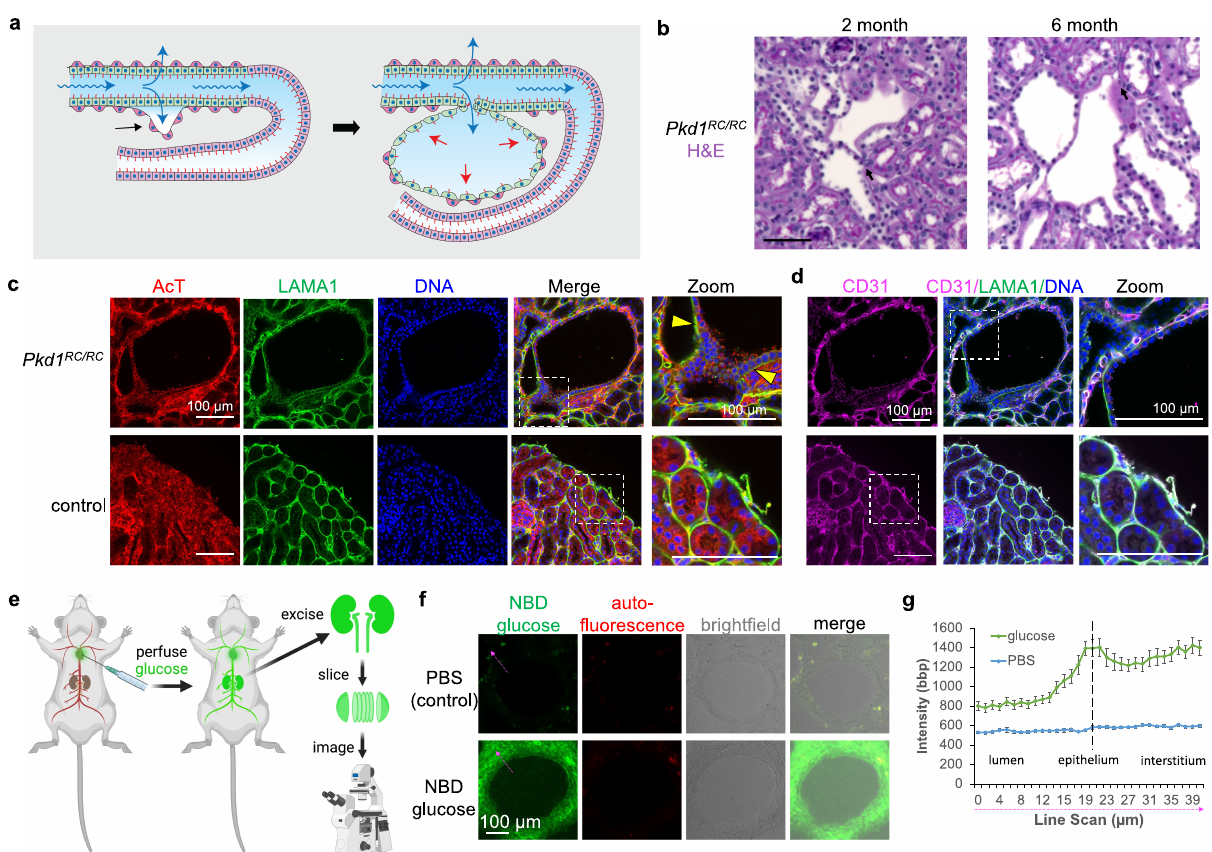
Fig. 6 | PKD cysts in vivo absorb glucose into the surrounding interstitium. a Hypotheticalschematicofabsorptivecystformationinkidneytissue.Fluid (blue arrows) is absorbed through proximal tubules into the underlying interstitium, which partially detach from the epithelium. The tubules then expand and deform to fi ll the interstitial space, reaching a low-energy conformation in which the withheld volume is ultimately transferred back into the luminal space of the nas- cent microcyst. A simpli fi ed model is shown and represents one possible expla- nationof the fi ndings. b PASstains of 2-month-oldand 6-month-old Pkd1 RC/RC mice (C57BL/6J background). Scale bars 50 µ m. Images are representative of 4 animals per condition (two male and two female). c Confocal images of stromal basement